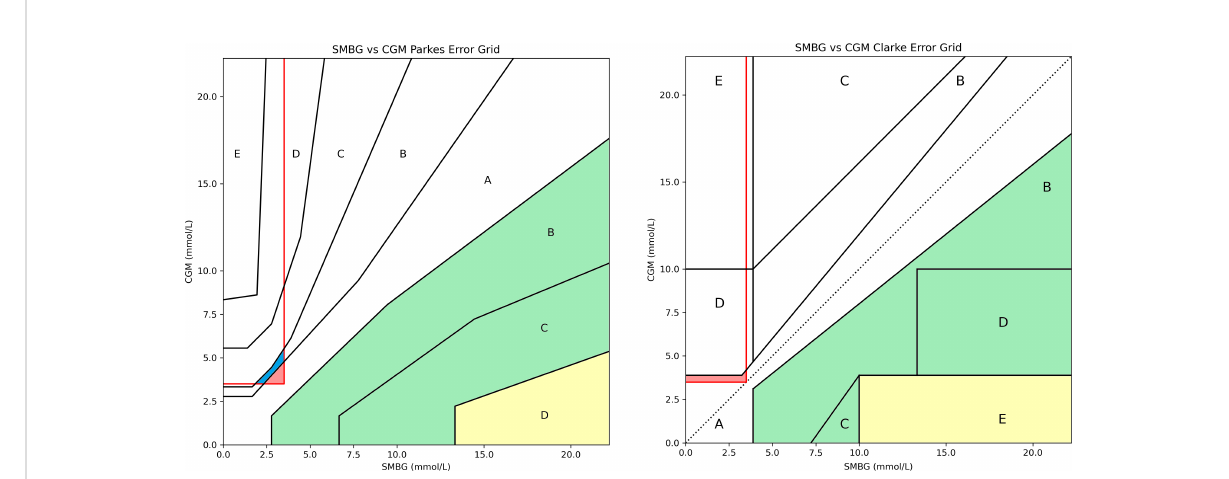
FIGURE 1 Parkes Error Grid (left) and Clarke Error Grid (right) demonstrating inappropriate risk areas for assessing CGM in CHI patients. For PEG: A = no effect on clinical outcomes, B = altered clinical action with little or no effect on clinical outcome, C = altered clinical action likely to result in altered outcome, D = altered clinical action could have signi fi cant medical risk, E =could have dangerous consequences. For CEG: A = values within 20% reference of the sensor, B = outside 20% but would not lead to inappropriate treatment, C = would lead to unnecessary treatment, D = potentially dangerous failure to detect hypo or hyperglycaemia, E = would confuse treatment of hypo for hyperglycaemia and vice versa. The red outlined box indicates false negatives for hypoglycaemia (<3.5 mmol/L).Both charts contain areas which categorise these false negatives as low risk (shaded blue) or no risk (shaded red) which, in reality, could be dangerous for a patient with CHI. Both charts also have large risk areas associated with missed hyperglycaemia which pose minimal risk (shaded yellow and green) to patients with CHI and could be re- categorised as risk A or